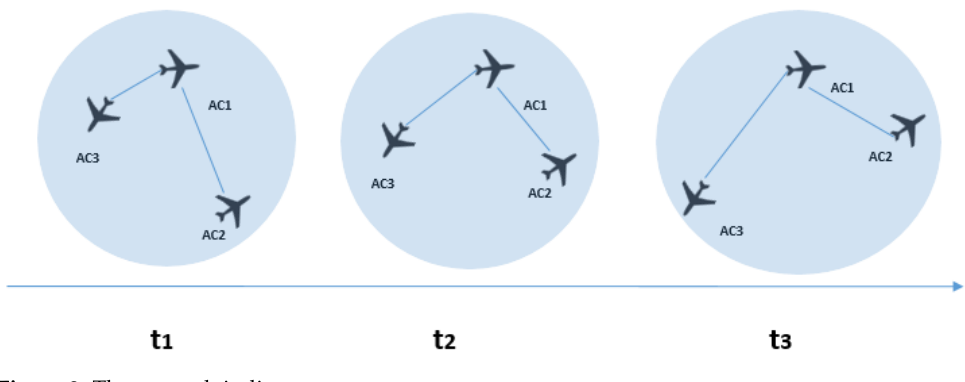
Figure 2. The strength indicator.